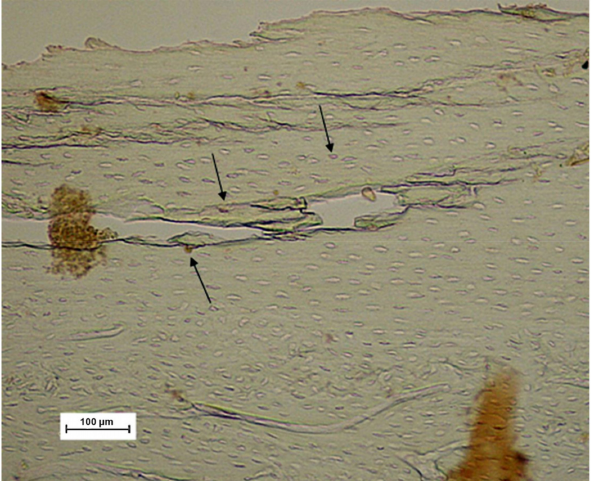
Figure 6. Representative image of the sample from the G2 group showing a microfracture in the bone. Black arrows denote the immunolabelled